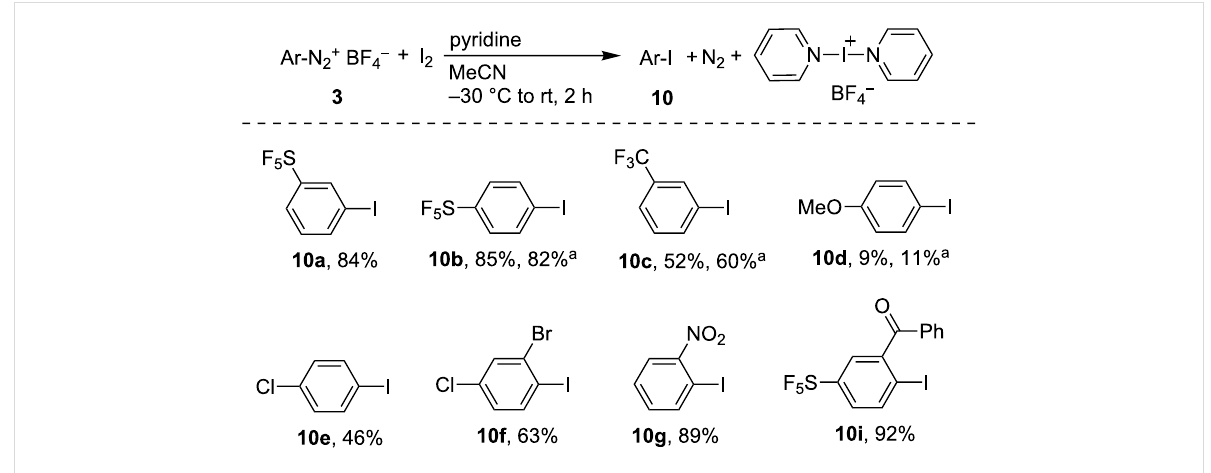
Scheme 6: Iodination of aryldiazonium tetrafluoroborates 3 . Reaction conditions: 3 (1 mmol), I 2 (1.1 mmol), pyridine (4 mmol), MeCN (3 mL), 2 h. a Yields in the presence of collidine instead of pyridine.